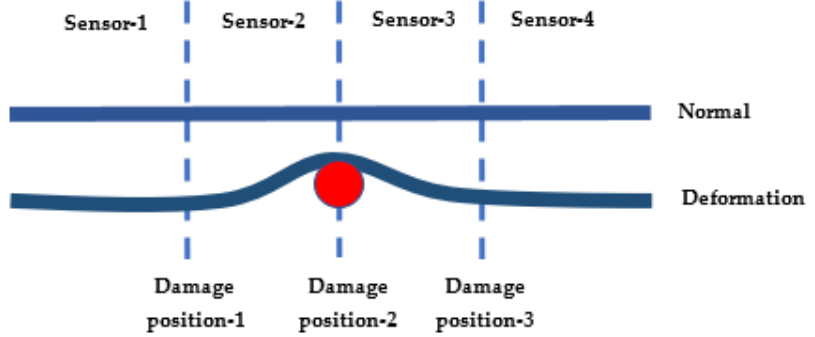
Figure 11. Test setup for bending detection.